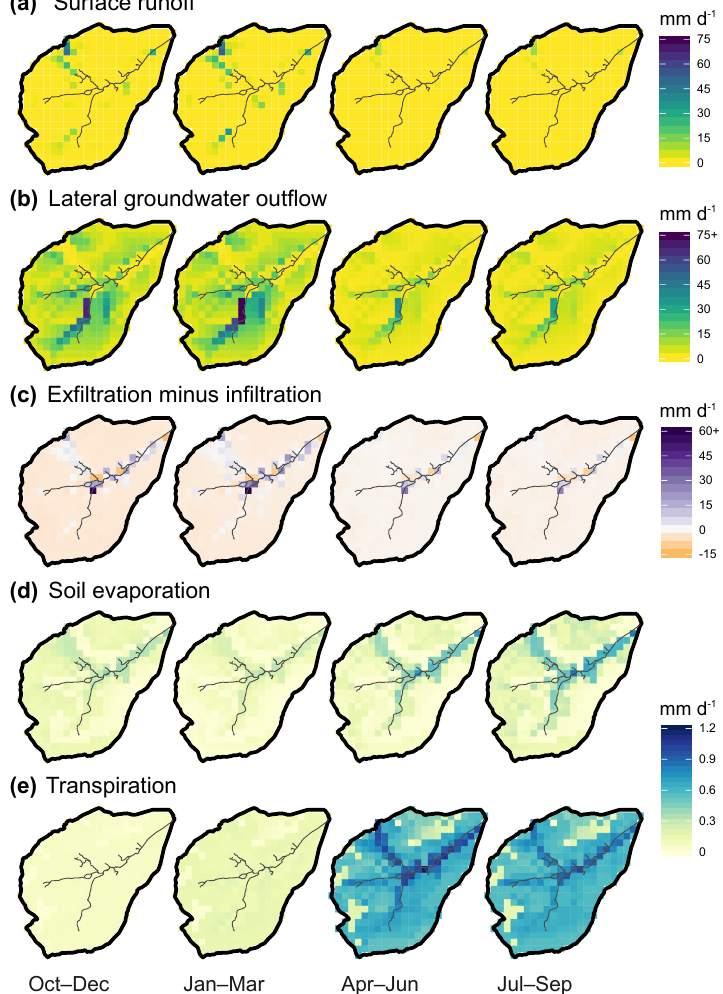
Figure 9. Seasonally averaged daily outgoing water fluxes in the Bruntland Burn over the period 2013–2016, showing the ensemble median of simulated (a, b) cell-to-cell lateral flow, (c) net vertical liquid flow, and (d, e) evaporative losses via soil evaporation and transpiration,